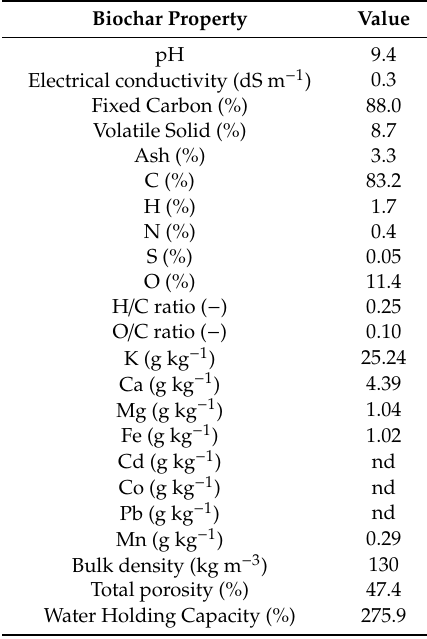
Table A1. Main physico-chemical properties of the biochar applied to